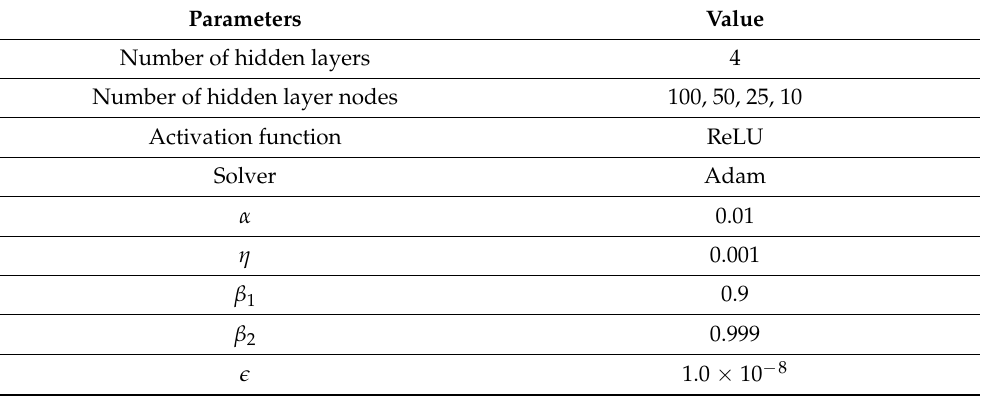
Table 5. Hyperparameters used for the learning model. Parameters Value Number of hidden layers